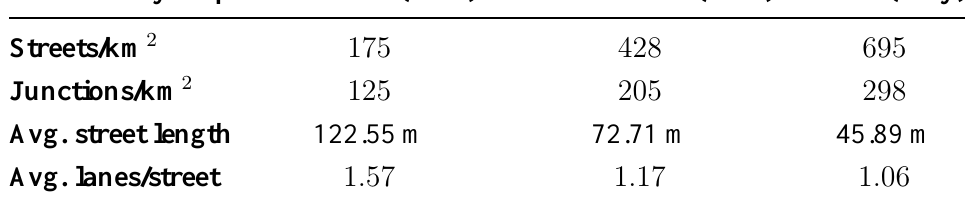
Table 9. Main features of the selected